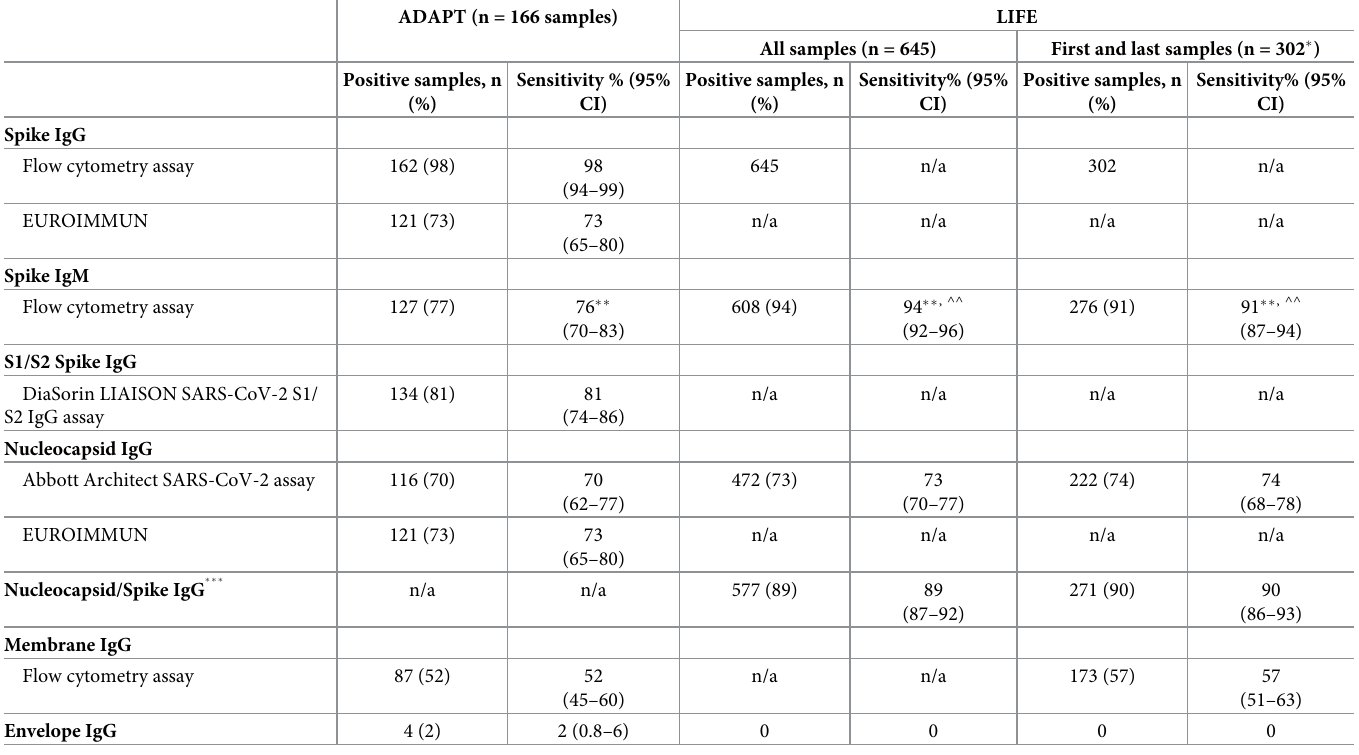
exhibiting a higher proportion of decreased profiles (Fig 1). The first collected sample in ADAPT started later post-PCR positivity, and the time duration between paired samples was shorter than for LIFE samples; therefore, some ADAPT patients may have been captured dur- ing the second, more stable, phase (Fig 1, Table 1). Furthermore, few ADAPT patients under- went plasmapheresis, whereas all LIFE donors underwent plasmapheresis as part of convalescent plasma donations (median 6 donations, IQR 3 to 9, max 14). However, donors Table 2. Comparison of the sensitivity of SARS-CoV-2 antibody detection